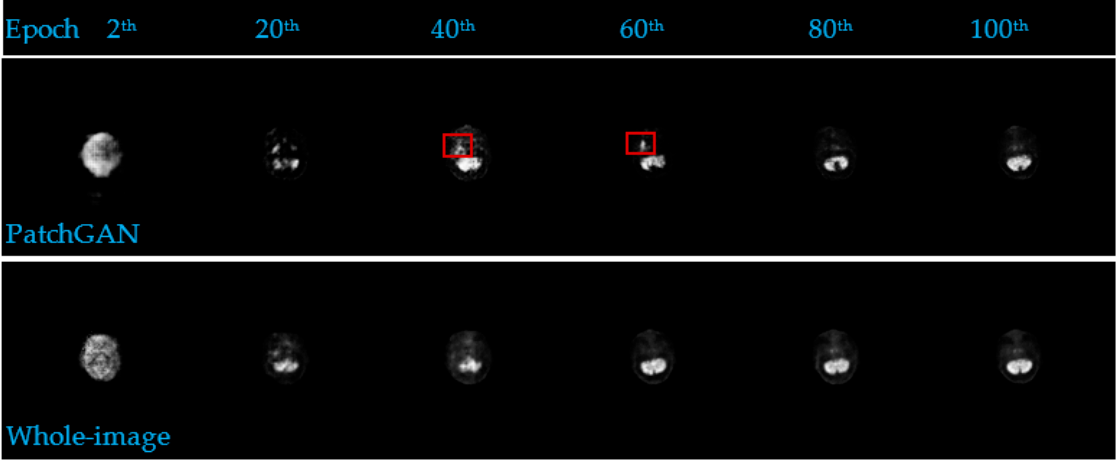
Figure 6. The images generated in training phase under two different strategies. The first column shows the real brain images generated with PatchGAN. The second column shows the brain images generated with the whole-image method. From left to right: the images generated in the 2nd epoch, 20th epoch, 40th epoch, 60th epoch, 80th epoch, and 100th epoch.